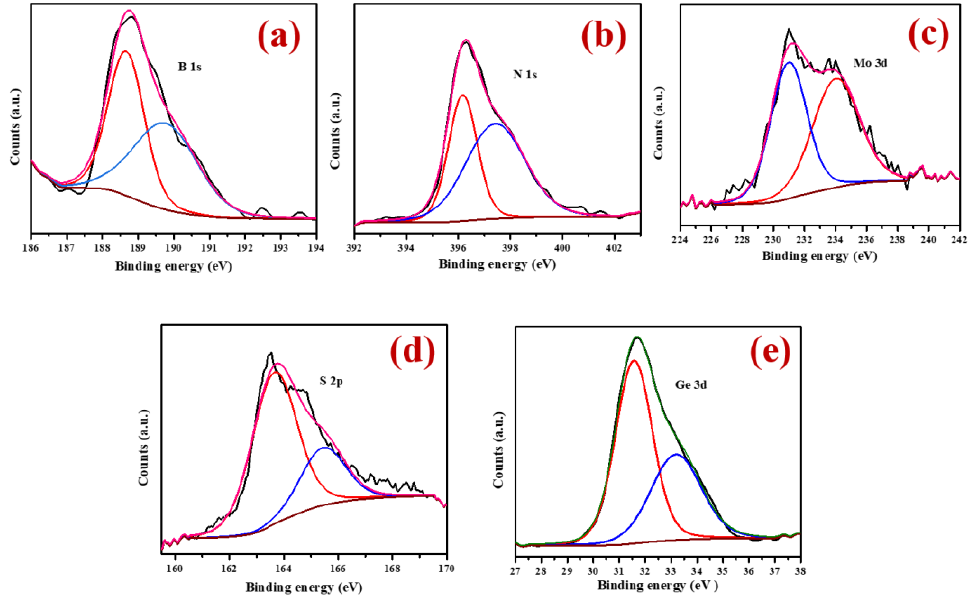
Figure 3. High-resolution ( a ) B 1s, ( b ) N 1s, ( c ) Mo 3d, ( d ) S 2p, and ( e ) Ge 3d XPS spectra of Ge/h- BN/MoS 2 . The presence of Ge 3d, Mo 3d, and S 2p features suggest the growth of Ge nanoparticles embedded into the h-BN/MoS 2 network.